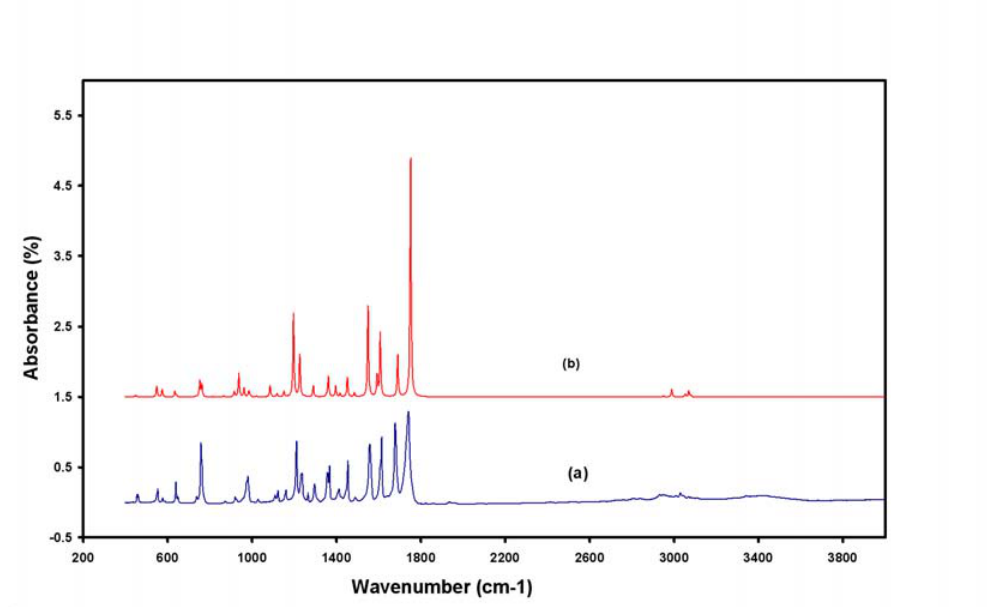
Fig. 2 FT-IR spectra of acetyl coumarin; (a) observed, (b) calculated.